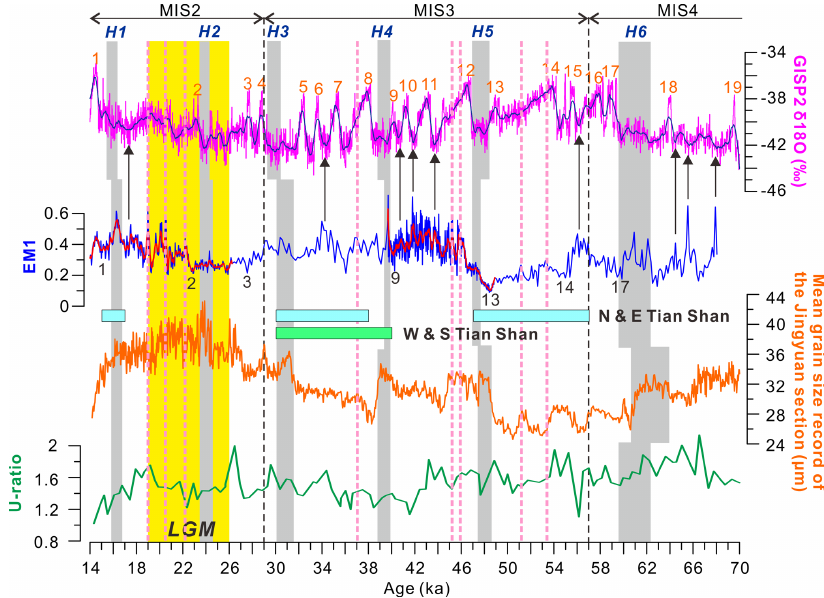
Figure 7. Comparison between EM1 grain size variability and the timing of glacial advances in the Tian Shan (Koppes et al., 2008; Owen and Dortch, 2014); stable oxygen isotope variations from the Greenland ice cores (Rasmussen et al., 2014); mean grain size (MGS) record of the Jingyuan loess section from the CLP (Sun et al., 2010) and; U-ratio (15.6–63.4µm / 5.61–15.6µm) of the SE Kazakhstan loess (Machalett et al., 2008). A five-point running average was performed for the intervals with higher sedimentary rate on EM1 curve (red